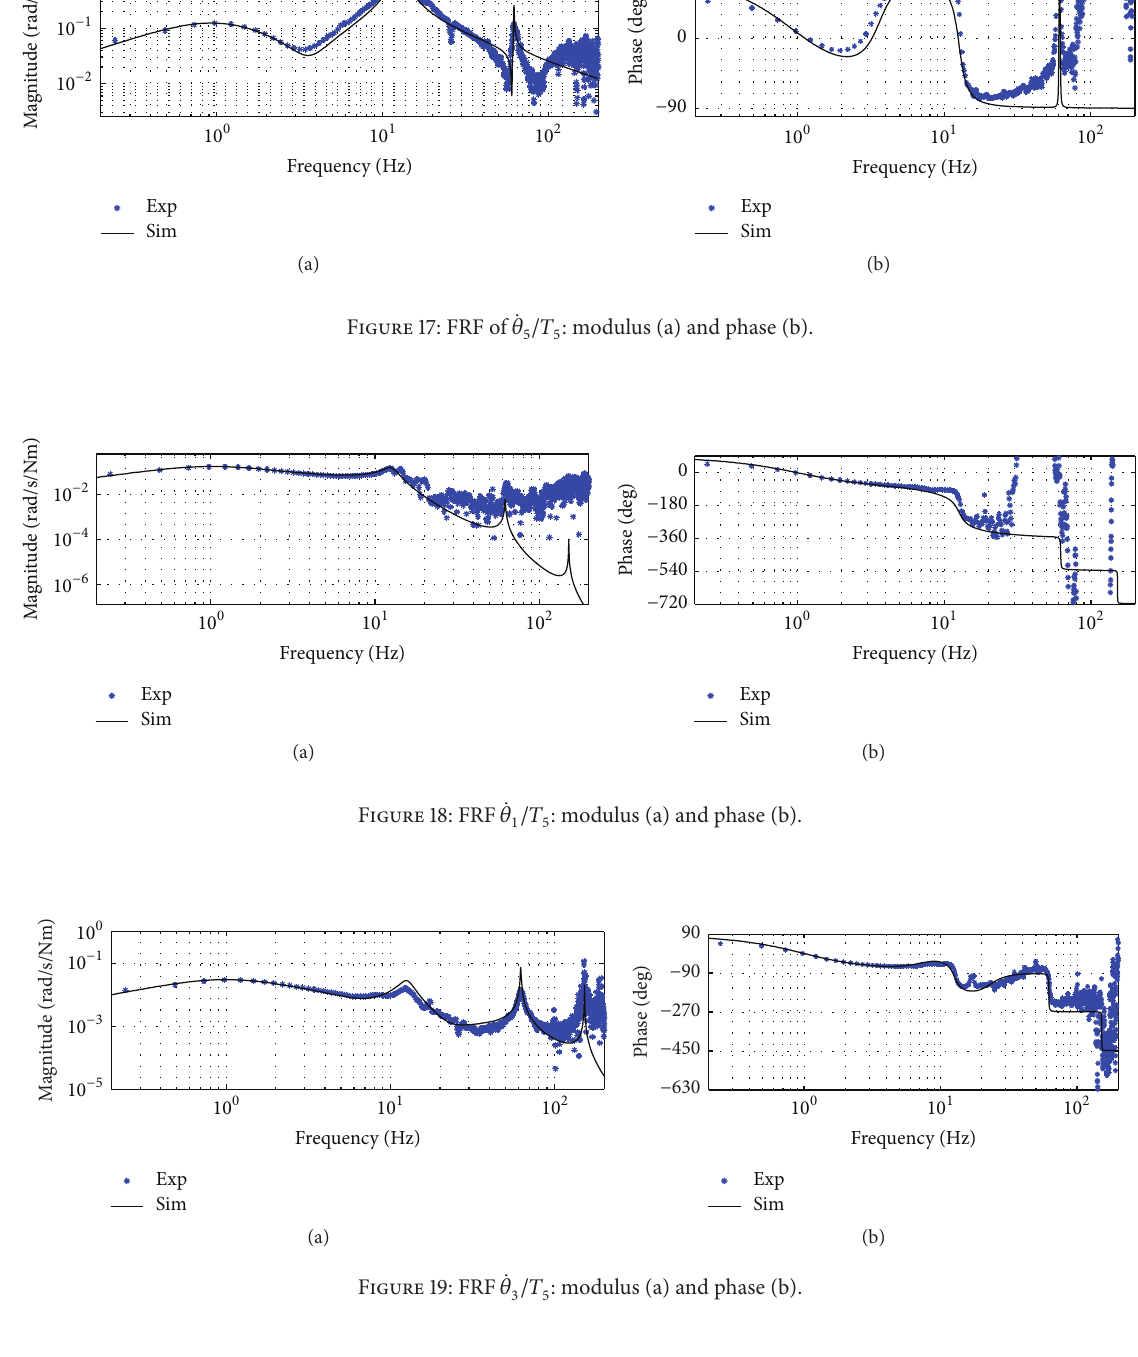
̇𝜃 /𝑇 3 5 : modulus (a) and phase